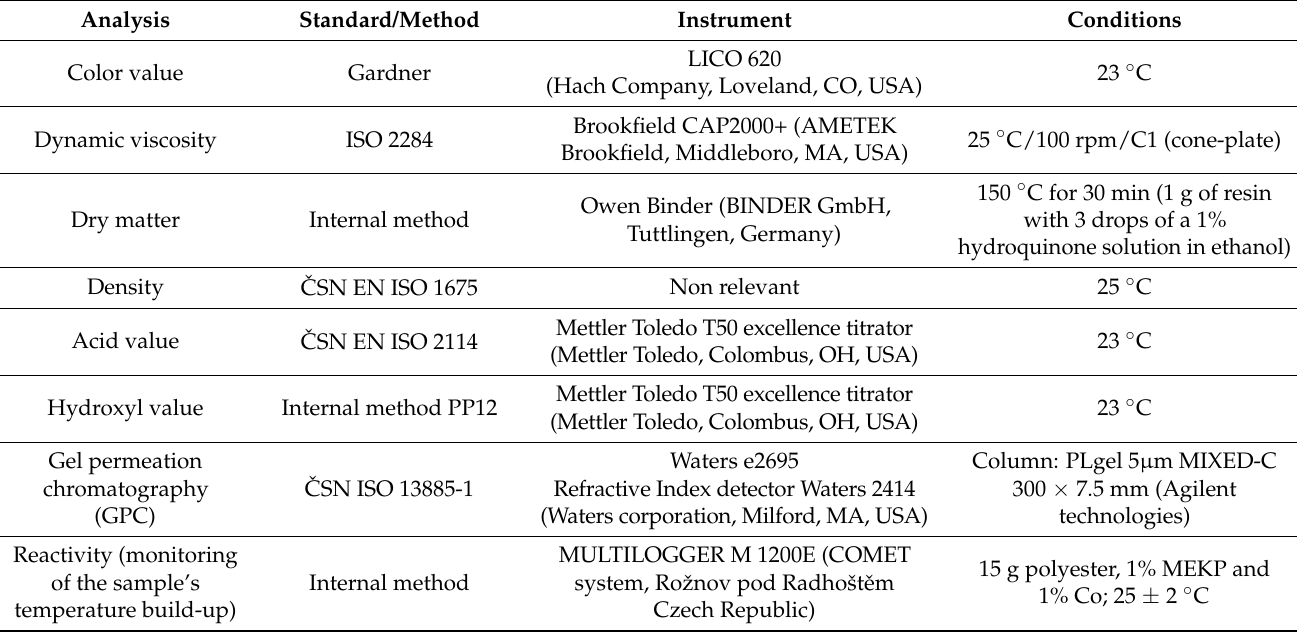
Table 5. Liquid resin (uncured) characterization.